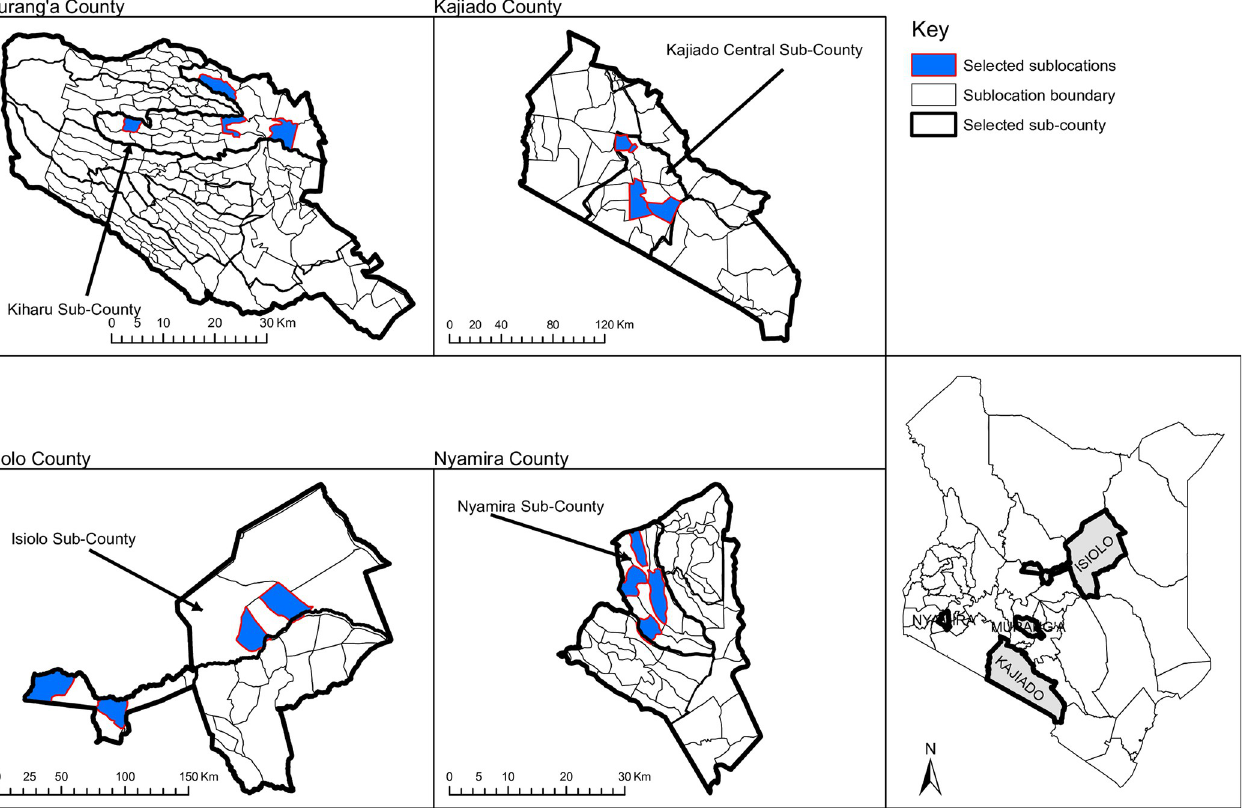
Fig 1. A map of Kenya showing the sampled study areas (sub-locations). The map for the study area was created using ArcGIS Desktop version 10.2.2 software (Environmental Systems Research Institute Inc., Redlands, CA, USA). Copyright © Esri. All rights reserved.